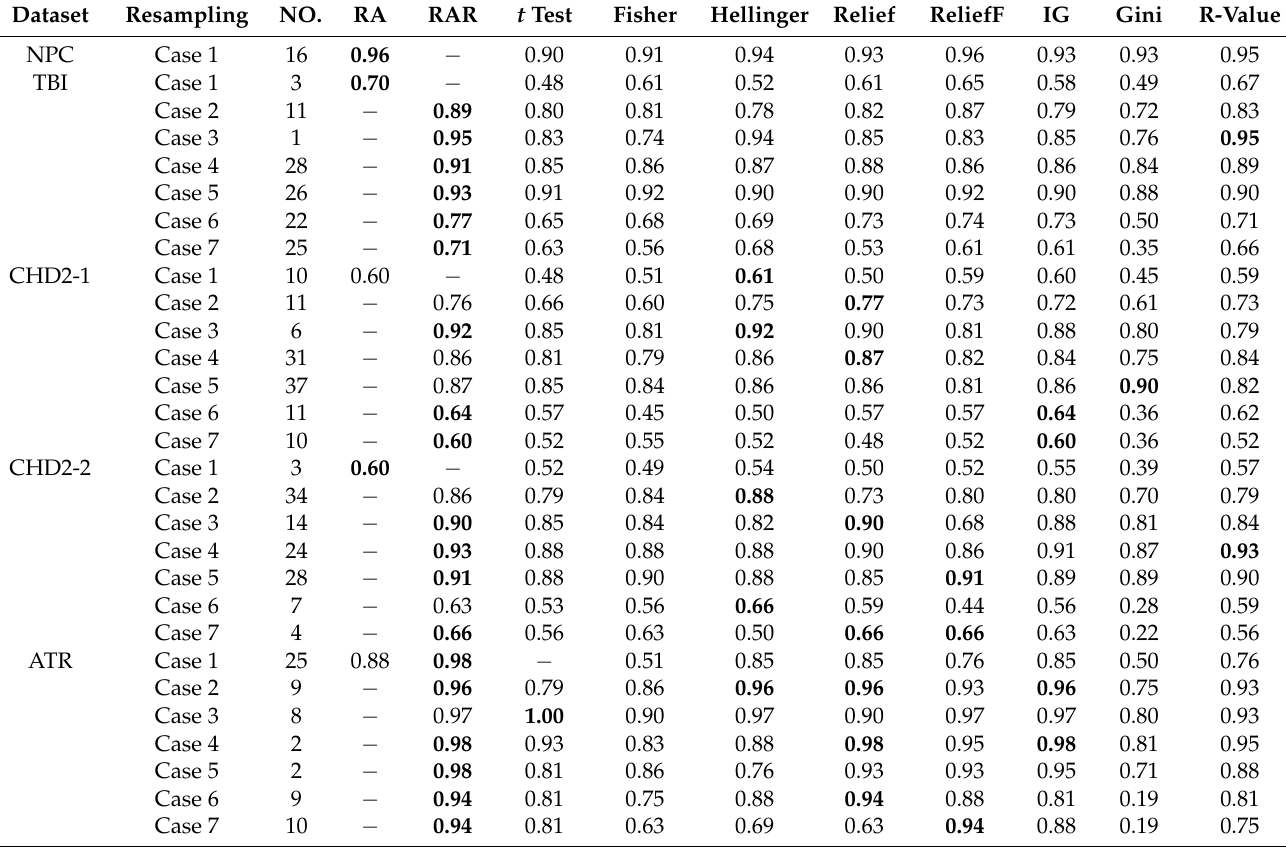
Table 3. AUCROC from rank aggregation and eight filtering techniques (The best result is in